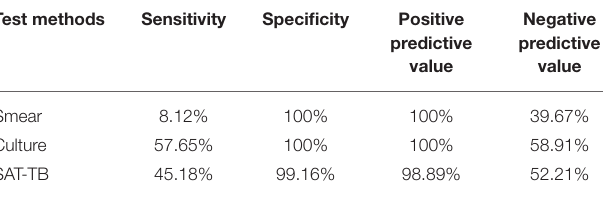
TABLE 3 | Accuracy of the three test methods for diagnosis of smear-negative